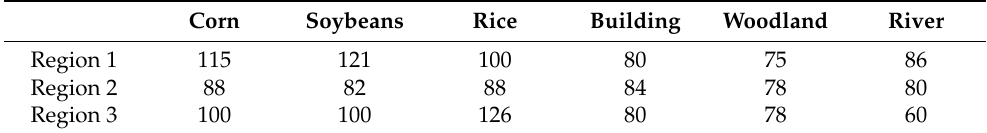
Table 3. Training samples in the three study areas. Corn Soybeans Rice Building Woodland River Region 1 115 121 100 86 Region 2 88 Region 3